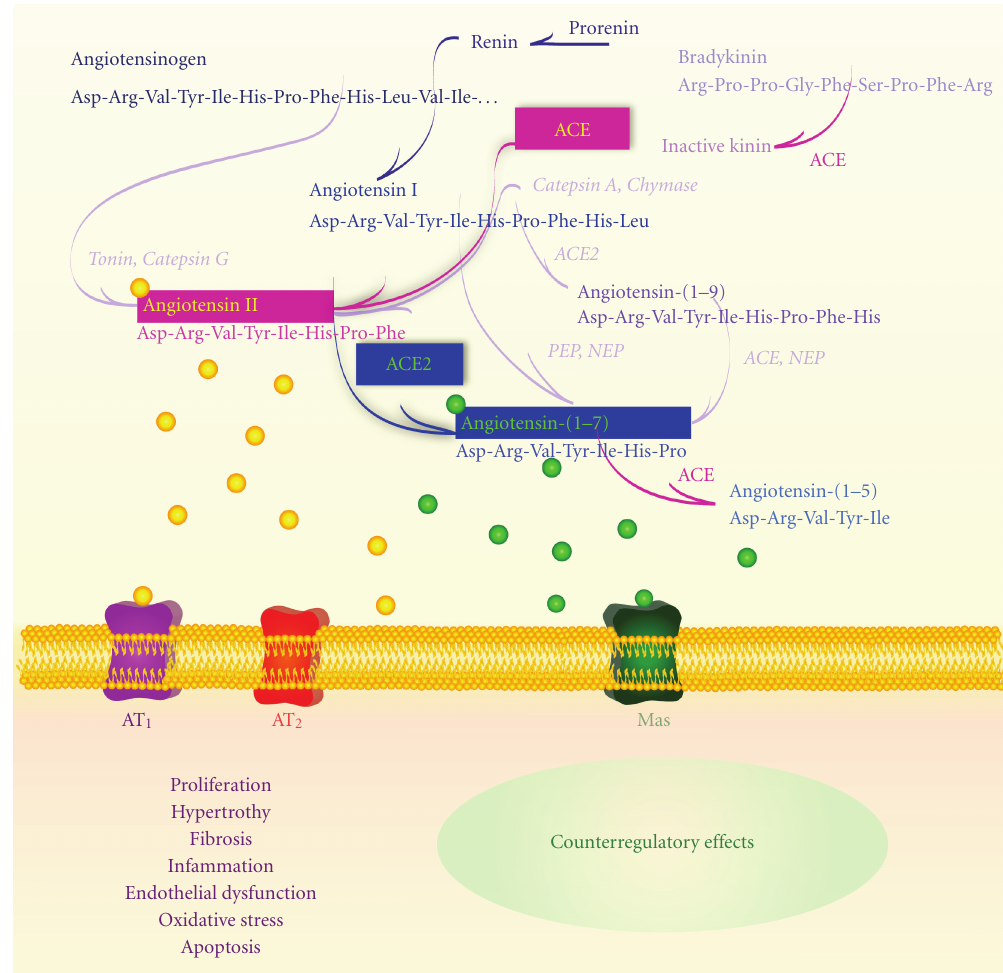
Figure 1: Schematic representation of the renin-angiotensin system (RAS) cascade. The counterregulatory axes of the RAS are composed by ACE/Ang II/AT 1 and ACE2/Ang-(1–7)/Mas. ACE: angiotensin-converting enzyme; Ang: angiotensin; AT 1 : Ang II type 1 receptor; AT 2 :